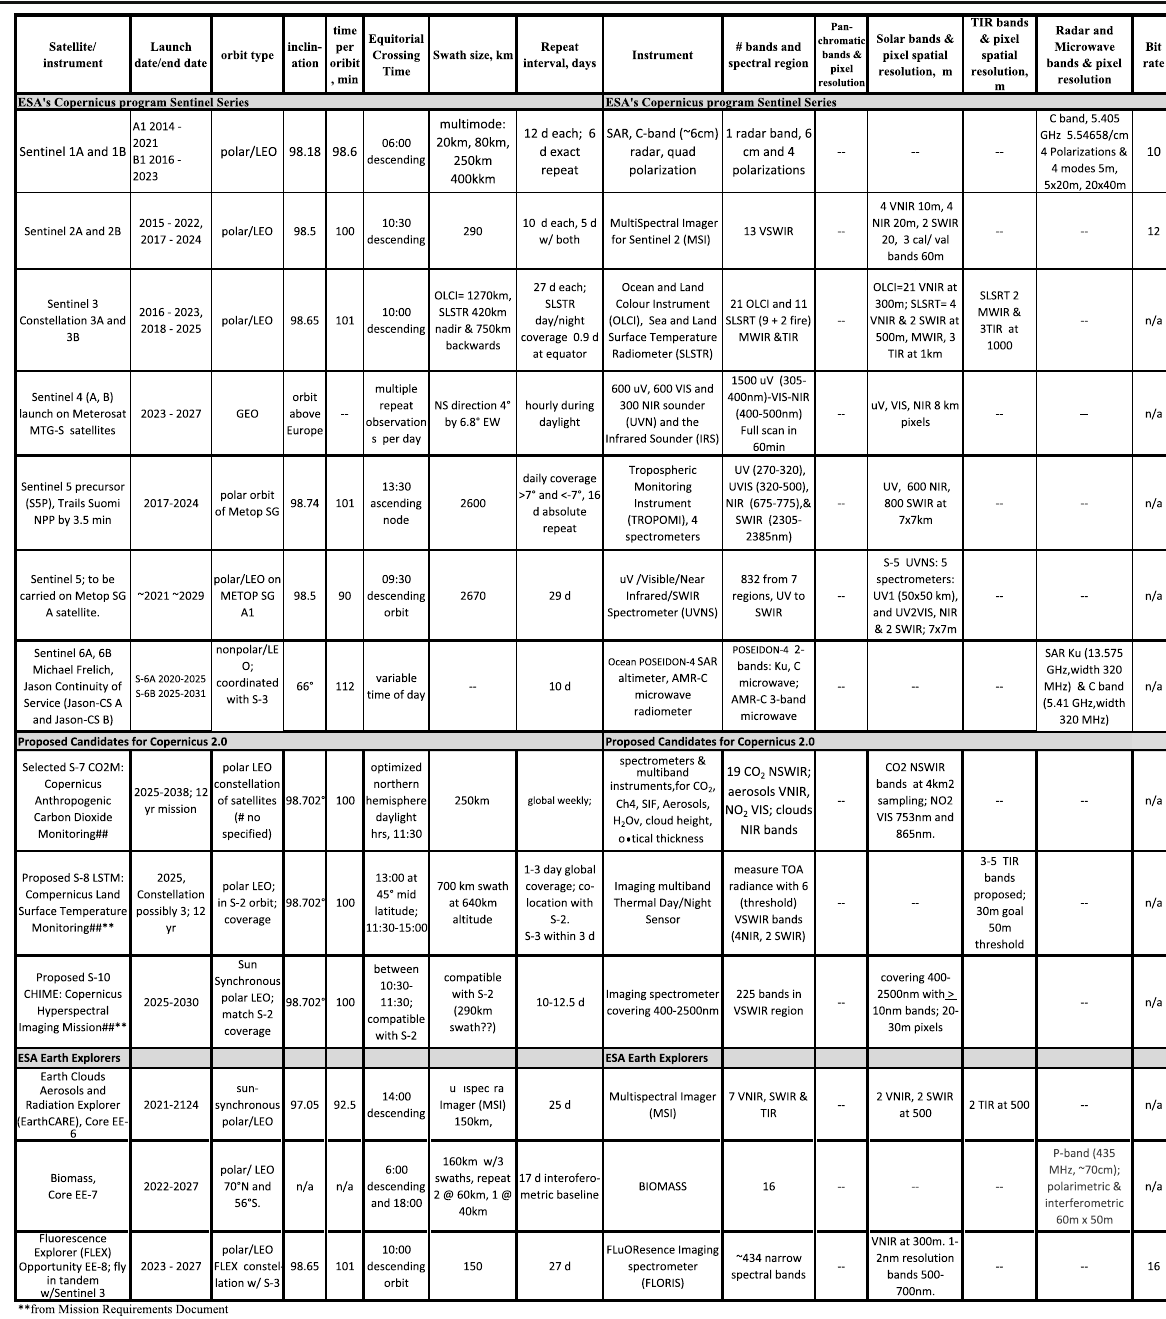
Table 3 European Space Agency ’ s Copernicus program of record